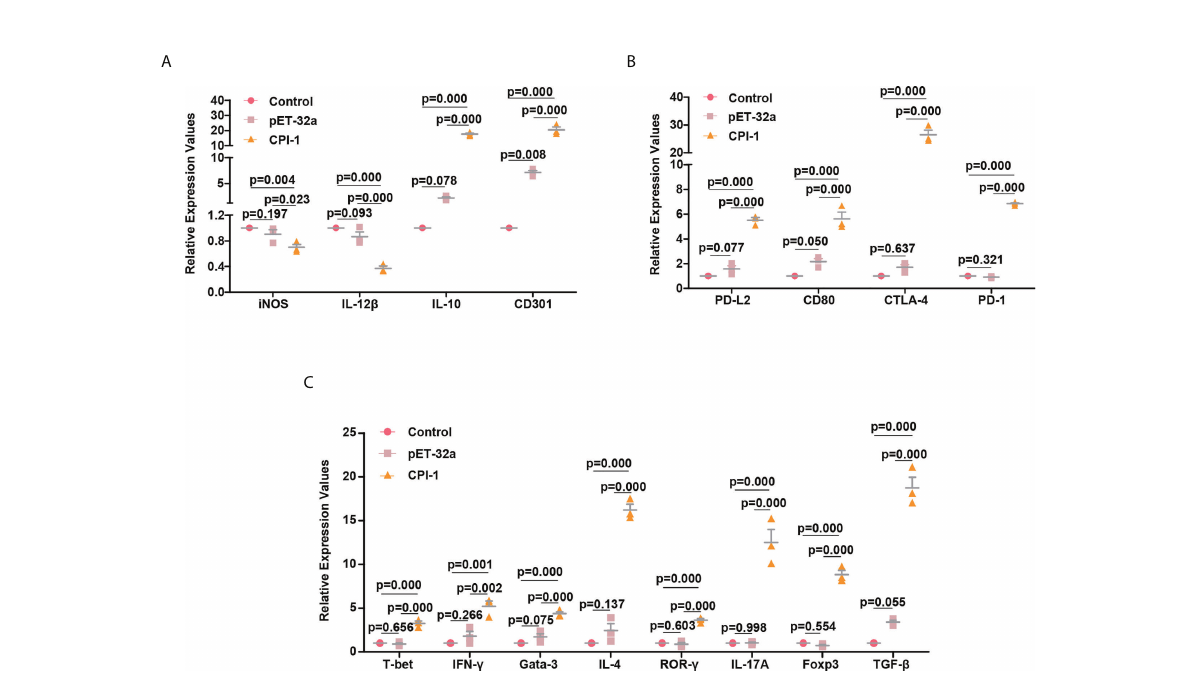
FIGURE 10 qPCR analysis of the polarization of MDMs and the differentiation of CD4+ T cells in vitro . The relative expression of M1 macrophage surface marker molecules (iNOS and IL-12 b ) and M2 macrophage surface marker molecules (CD301 and IL-10) (A) ; regulators of the immunoregulatory pathway (PD-L2, PD-1, CD80, and CTLA-4) (B) ; and cell surface marker molecules for Th1 cells (T-bet and IFN- g ), Th2 cells (Gata-3 and IL-4), Th17 cells (ROR- g and IL-17A), and Treg cells (Foxp3 and TGF- b ) (C) were detected by qPCR. The data are shown as the mean ± SD of 3 repetitions per